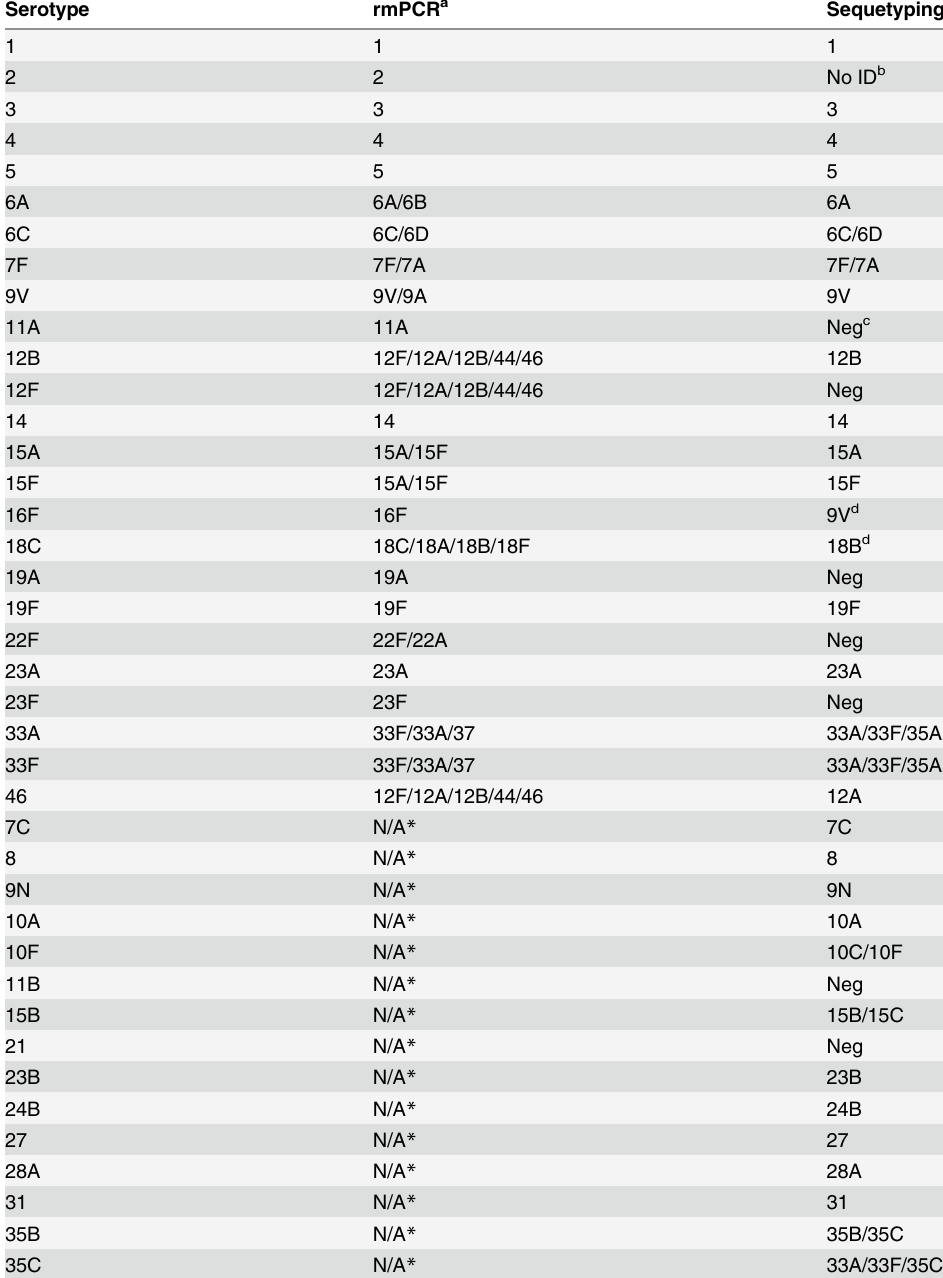
Table 1. Concordance of molecular serotyping results of pneumococcal control